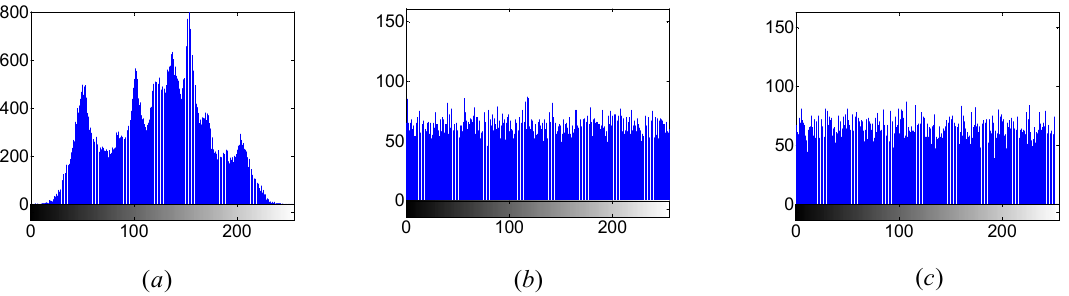
Figure 3. Histograms of Lena and the generated shares. ( a ) The histogram of “Lena” ( b ) the histogram of shares in G 1 ( c ) the histogram of shares in G 2 .